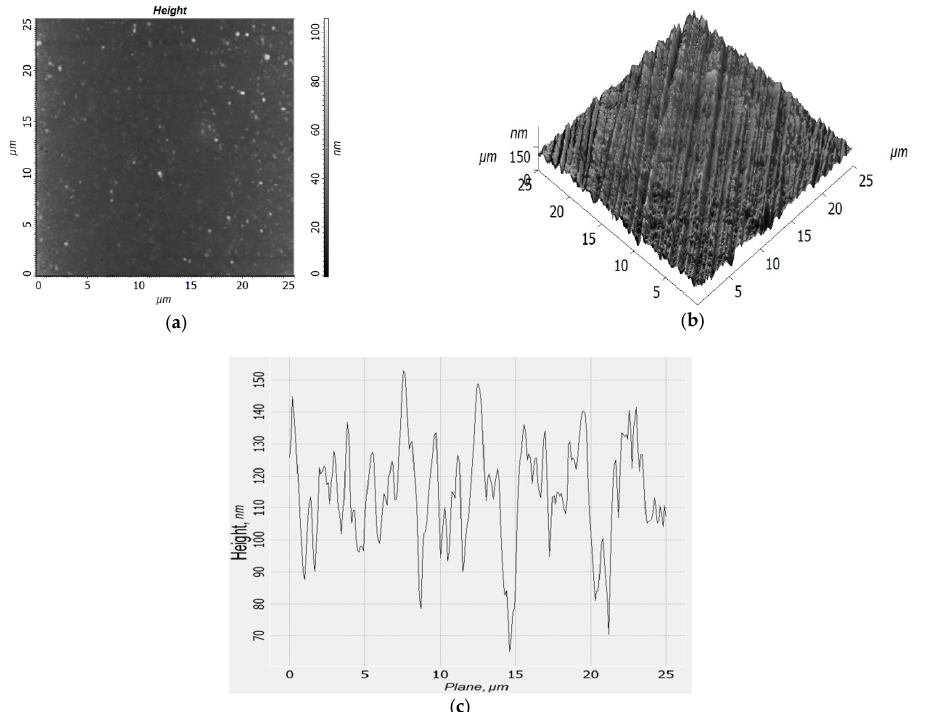
Figure 7. AFM images of the surface relief of spherical titanium hydride, non-modified: ( a ) 2D topographic image, ( b ) 3D topographic image and ( c ) Surface profile.